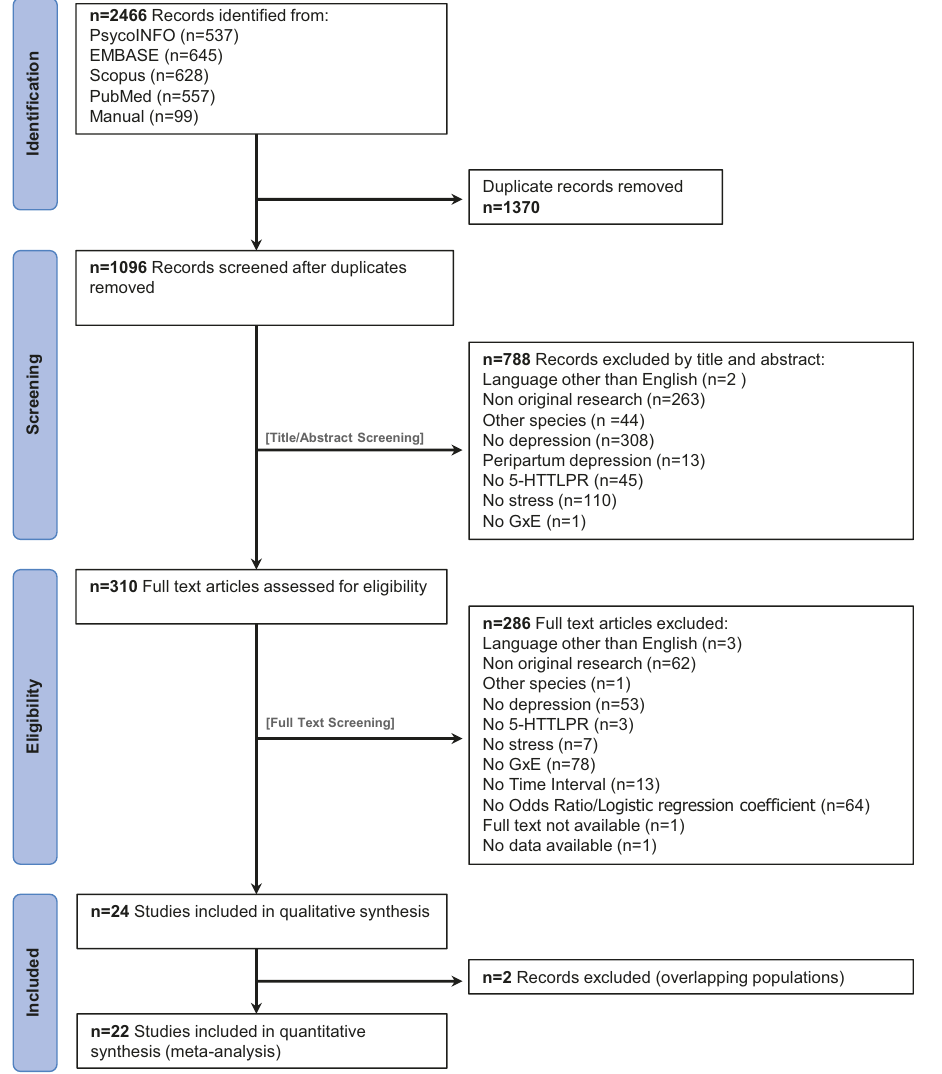
Fig. 1 PRISMA fl ow diagram. Diagram of the literature search (identi fi cation) and selection process (screening, eligibility,